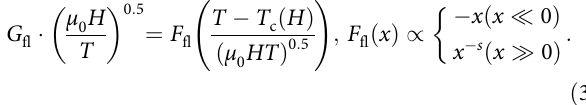
Fig. 7 Magnetoconductivity of AuSn 4 . Field-dependent transverse magnetoconductivity change ratio for AuSn 4 at low temperatures. Solid lines denote the fi tting of WAL formula. Inset: temperature dependence of obtained a values via the fi tting of WAL